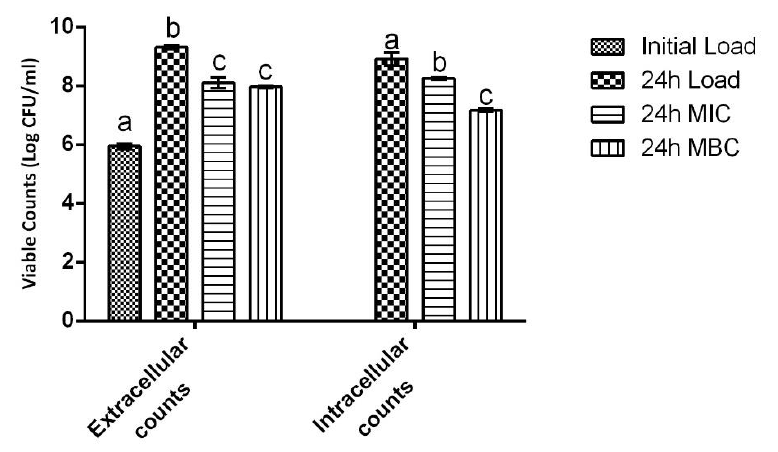
Figure 6. Effect of NDYE, at MIC and MBC concentraions, upon MRSA infection of HaCat cells. Results are given in terms of total bacterial counts. Different letters represent statistically significant differences found ( p < 0.05) between the tested conditions.